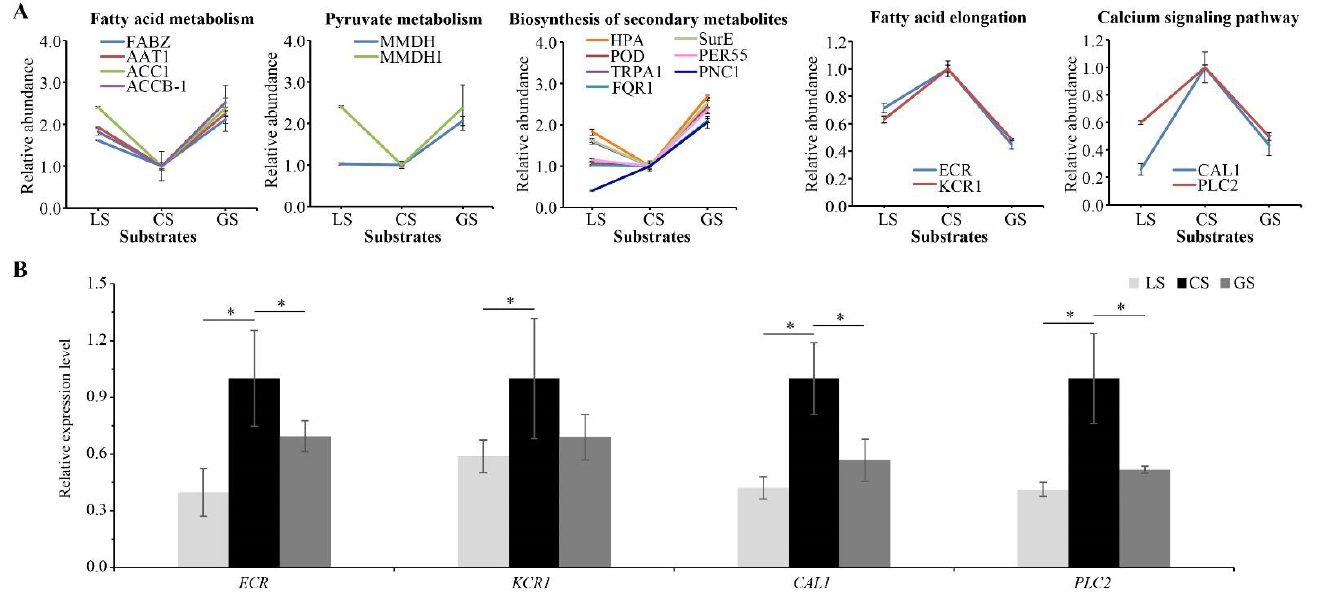
Figure 7. Effects of substrates on proteins related to nutrient metabolism and secondary metabolism: ( A ) related protein abundance levels; and ( B ) RT-qPCR analysis of four related proteins. Error bars represent the SD of the quantitative mean value of proteomic and RT-qPCR results. * represents a significant difference with the p value < 0.05.